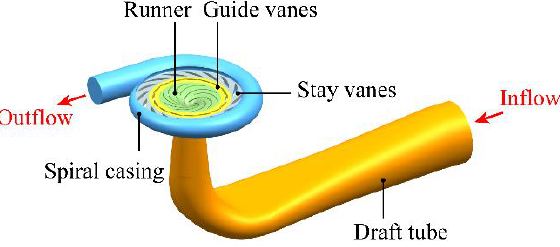
Figure 2. Three-dimensional computational domains of the pump-turbine.